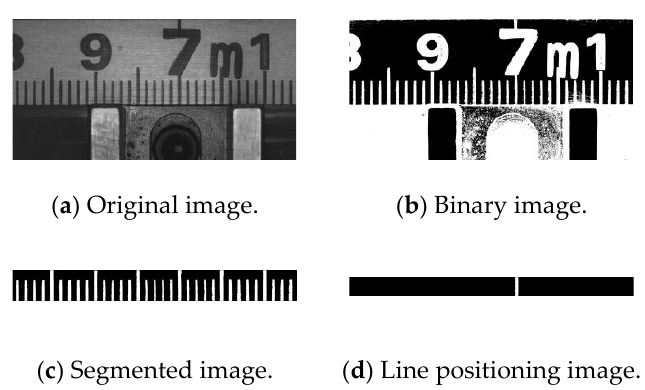
Figure 11. Highest scribed line recognition.